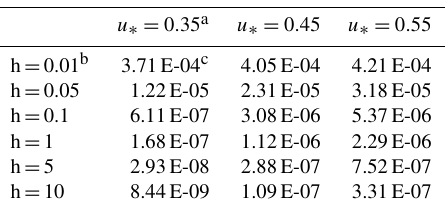
Figure 11. Vertical profiles of sublimation rate for saltation and sus- pension: (a) saltating particles; (b) suspended particles. Table 2. Sublimation rate at 1500s for snow particles at various heights.